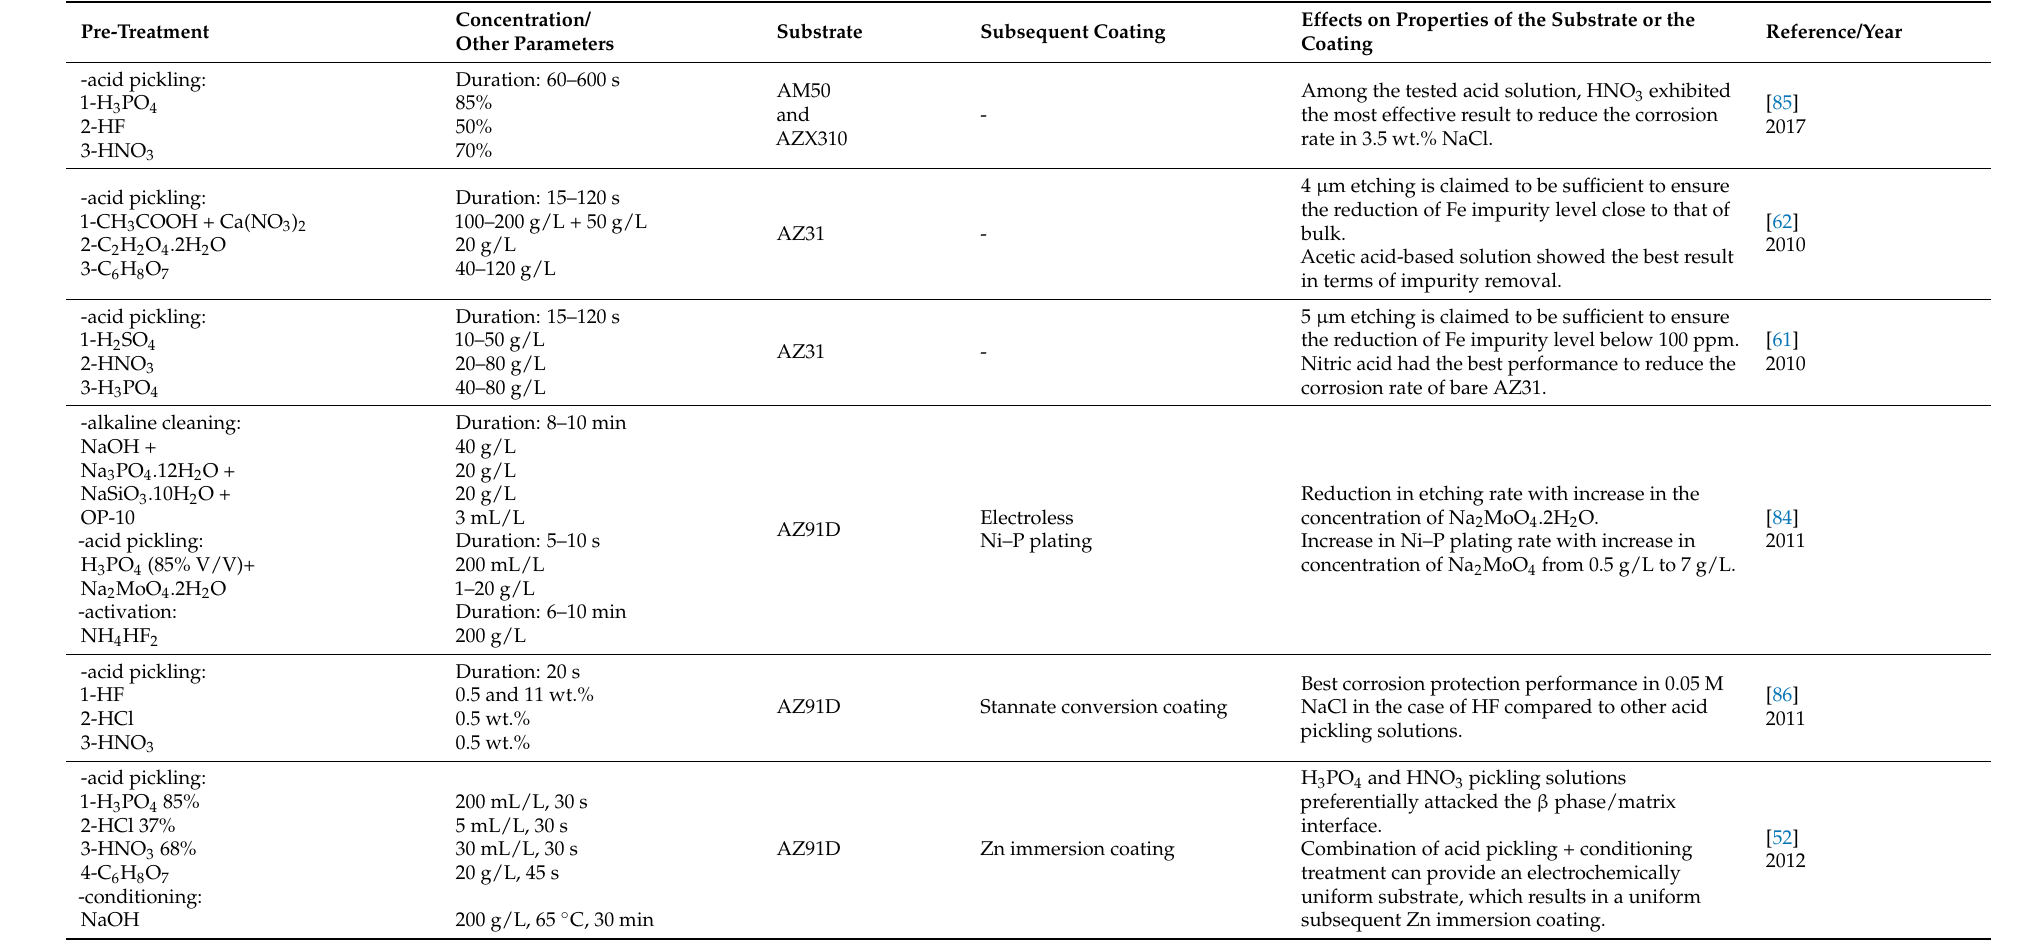
Table 1. Overview of the selected pre-treatment procedures reported in the